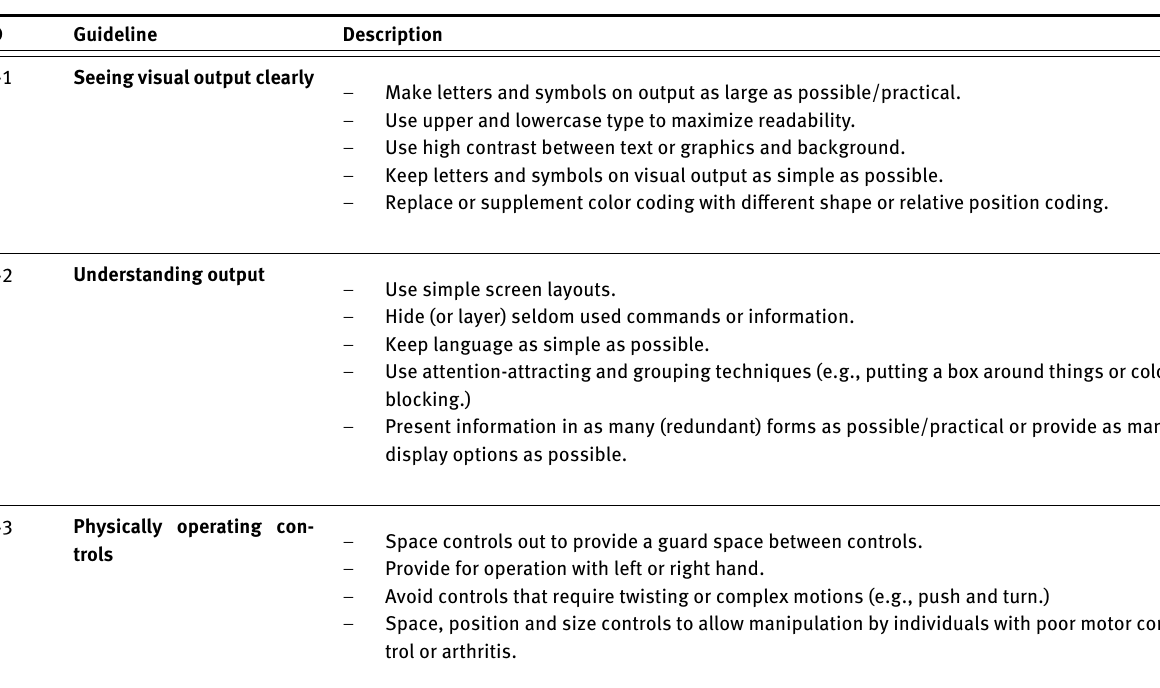
Table 12. Relevant Vanderheiden and Vanderheiden’s Guidelines for the Design of Consumer Products to Increase Their Accessibility to Persons with Disabilities or Who Are Aging [83] (Part 1 of